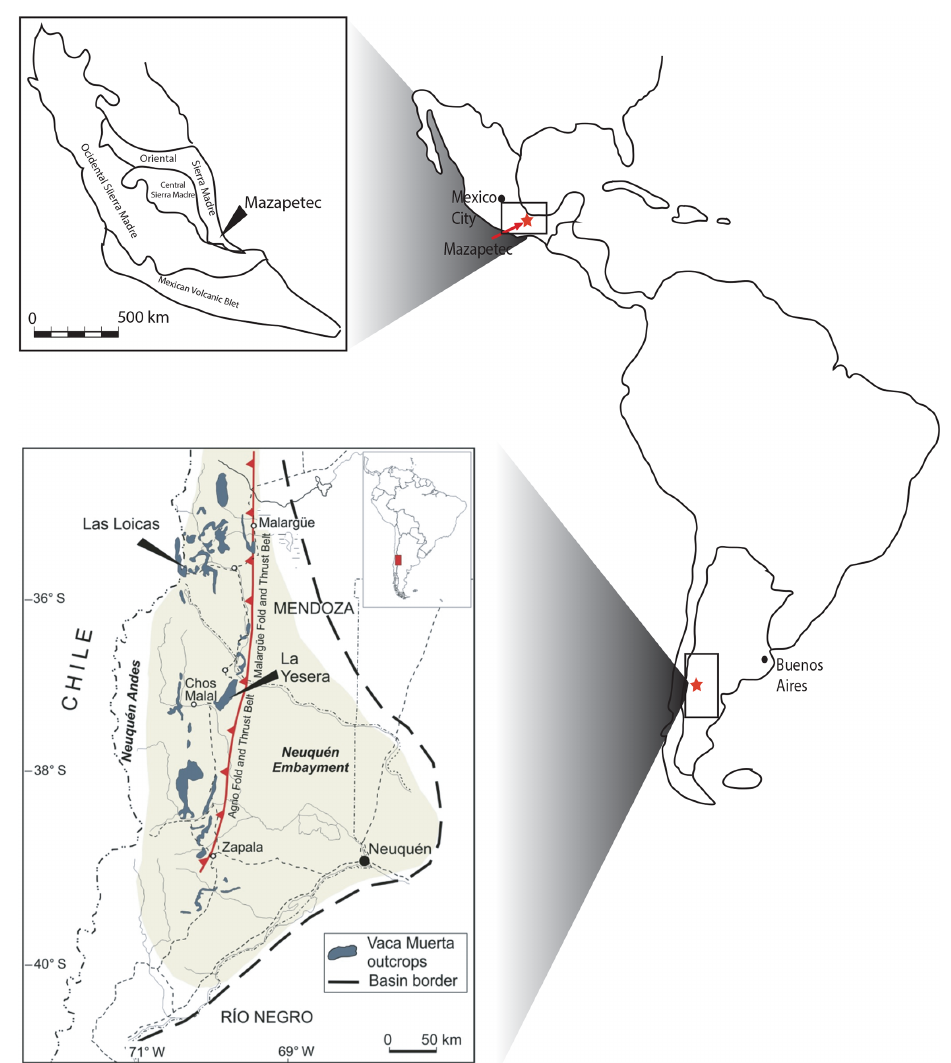
Figure 1. Location of the studied sections and the general geological context of each